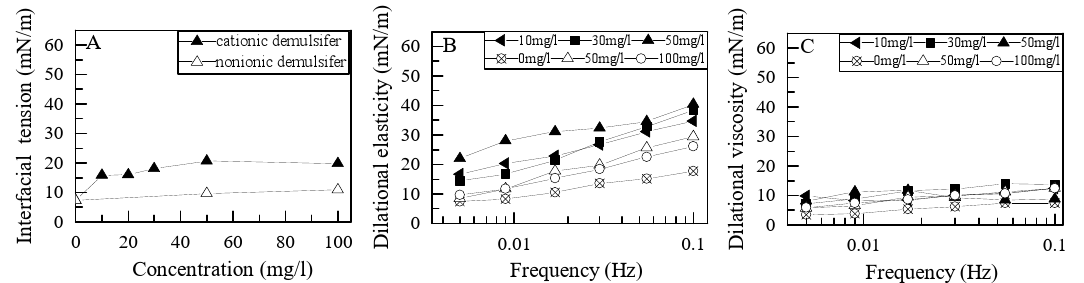
Figure 7. Interfacial tension and dilational rheology properties as a function of demulsifier concentration. ( A ) Interfacial tension, ( B ) dilatational elasticity, and ( C ) dilatational viscosity. The water phase contained 30 mg/L petroleum sulfonate and 100 mg/L HPAM and the oil phase was n-decane. The filled symbols represent the system with a cationic demulsifier CP-1 and the blank symbols represent the nonionic demulsifier NP-4.